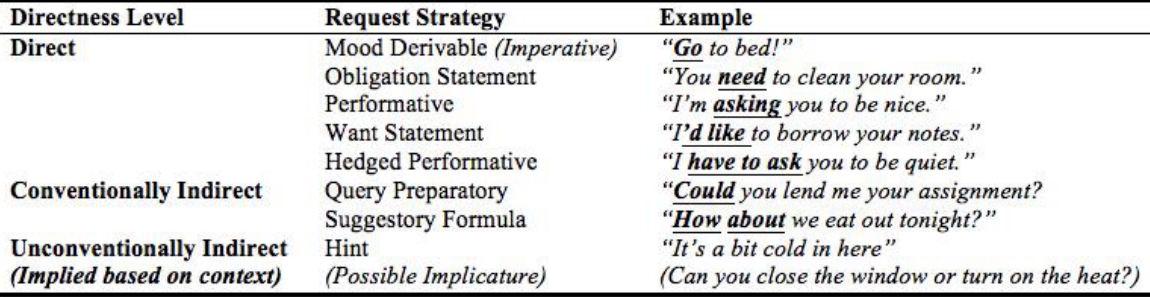
Head Act Taxonomy: Direct and Indirect Request Strategies Adapted from Blum-Kulka, House, and Kasper (1989, p. 278-281)